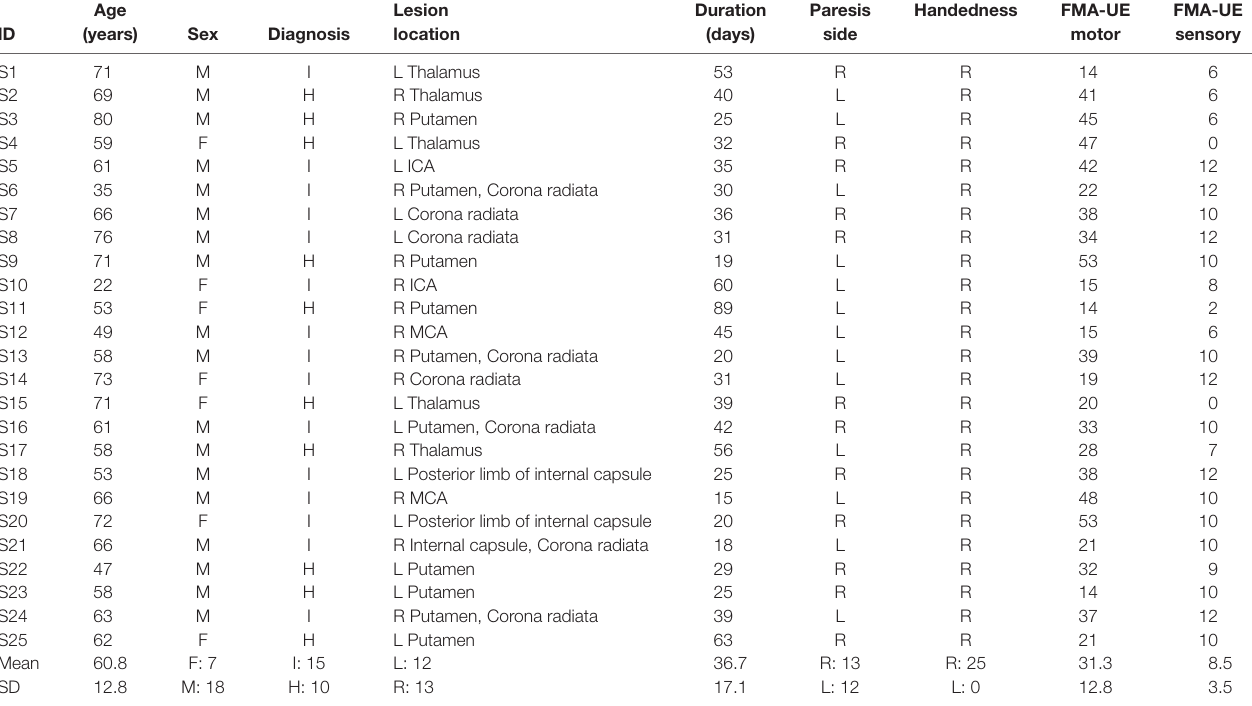
TABLE 1 | Clinical characteristics of stroke